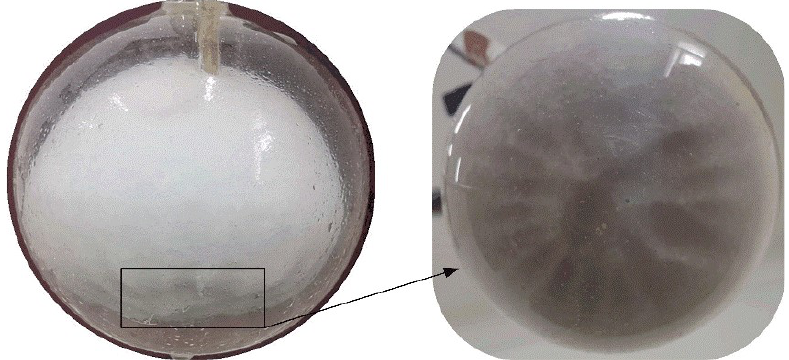
Figure 5. Transient shapes of the solid paraffin for the constrained melting inside the spherical con- tainer with 𝑅 = 31.02 mm and 𝑇 (cid:3050) = 318.15 K .